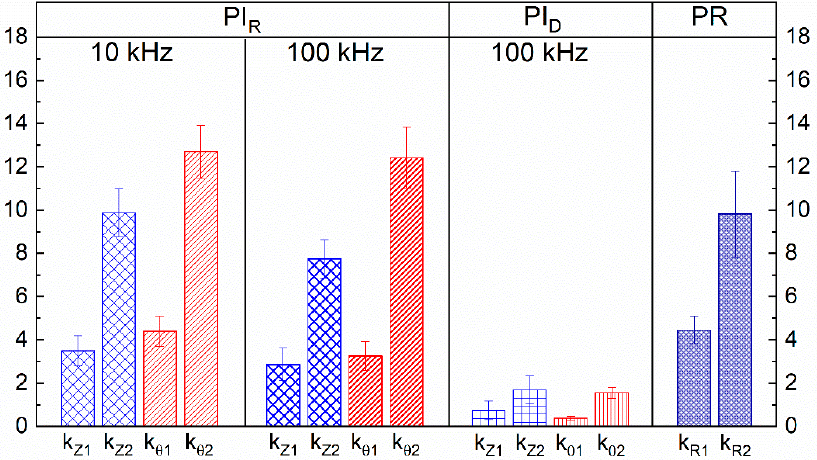
Figure 6. Sensitivity factors for 4 wt.% MWCNT/PP composites in the AC resistive configuration (PI R ), AC dielectric configuration (PI C ), and DC (PR).